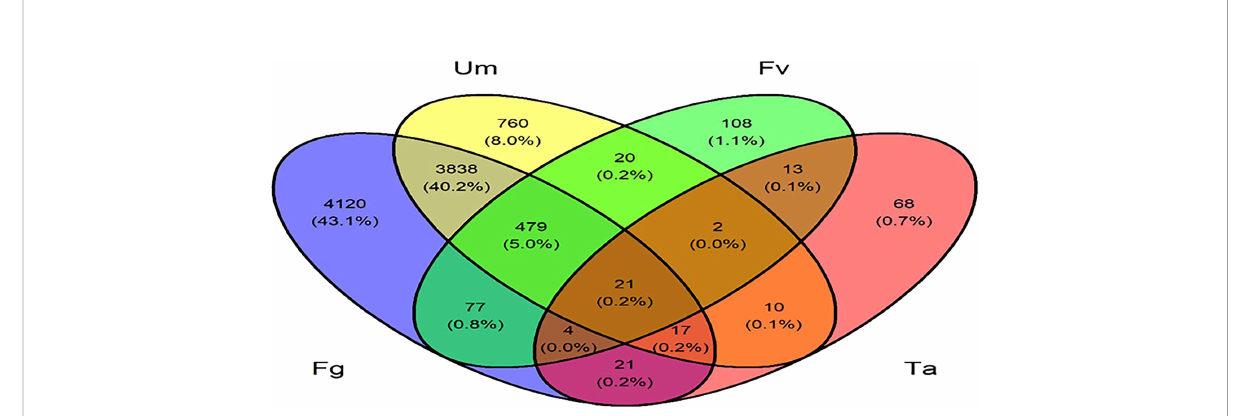
FIGURE 2 Venn diagrams of differentially expressed genes; the numbers in parentheses represent the total number of upregulated or downregulated genes in each combination of fungal infection in silk of Z. mays . Fg, F. graminearum ; Fv, F. verticillioides ; Ta, T. atroviride ; Um, U. maydis .